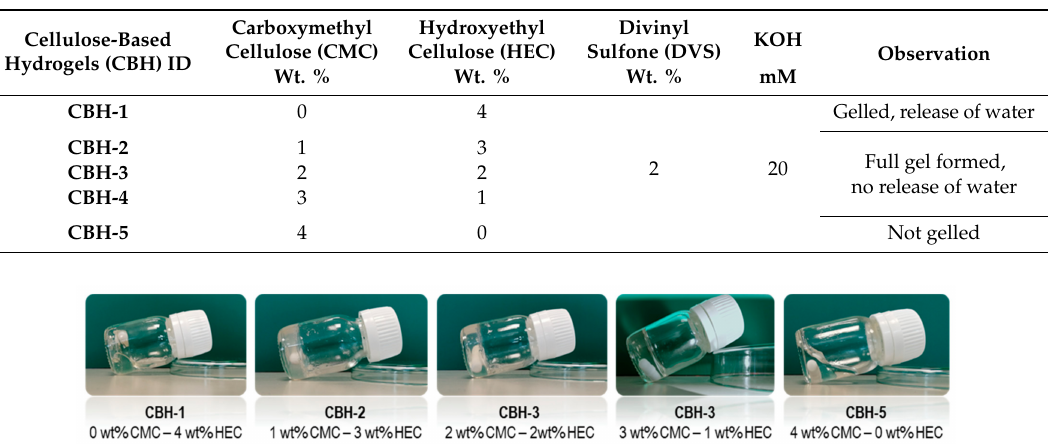
Table 1. Influence of the cellulose derivatives’ weight ratios on the gel formation and appearance.